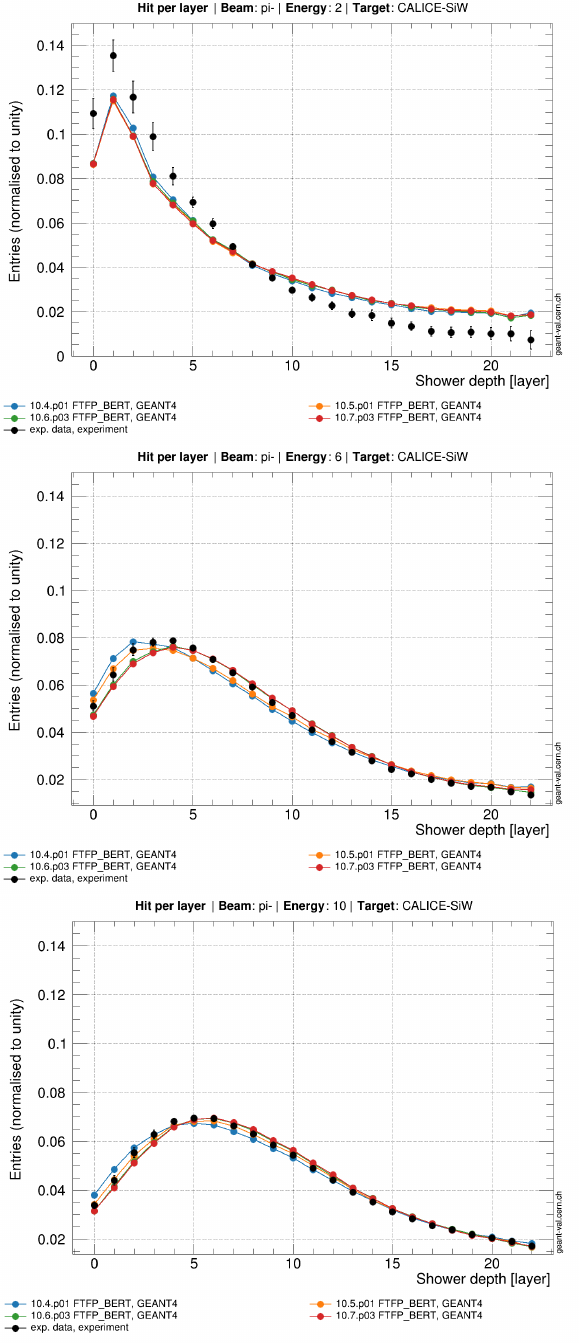
Figure 8. Longitudinal hit profiles for 2 ( top-left ), 4 ( top-right ), 6 ( center-left ), 8 ( center-right ), and 10 ( bottom-left ) GeV π − events. Results from experimental measurements and Geant4 simulation with the FTFP_BERT PL and releases from 2017 to